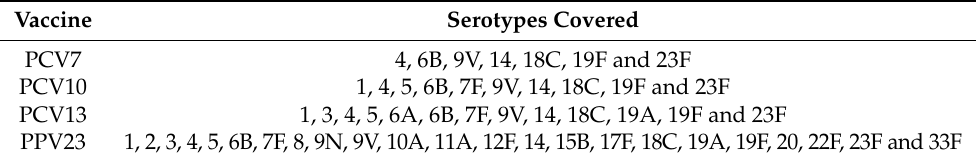
Table 1. Pneumococcal vaccines and the serotypes covered by each of them.